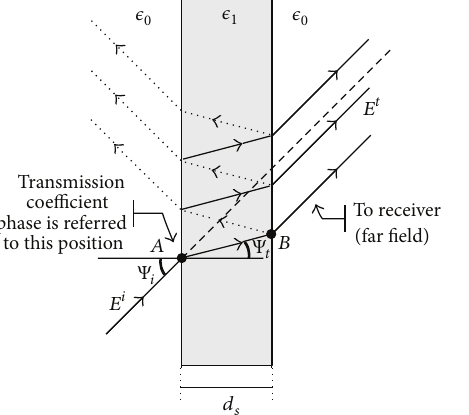
Figure 1: IMR transmission model for concrete and soil slabs.